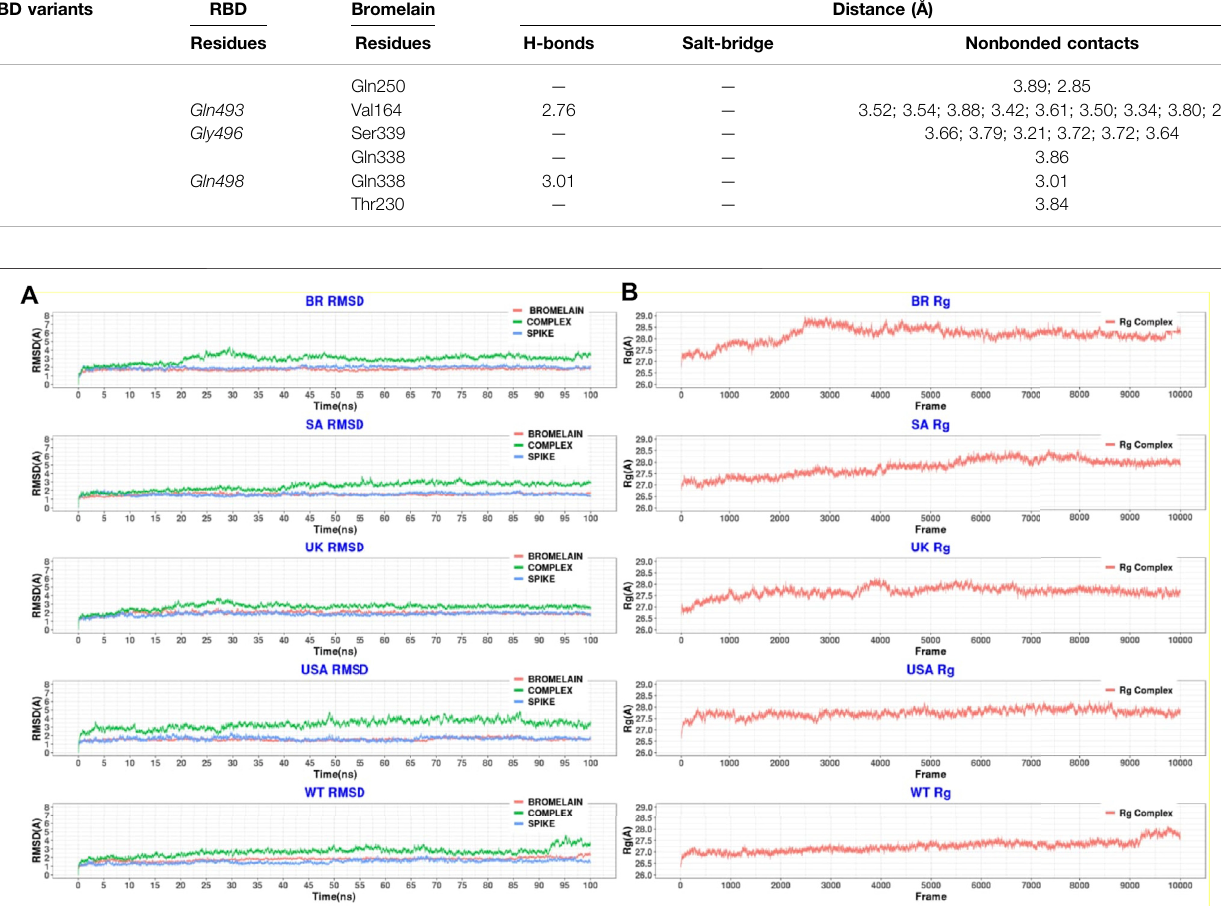
Frontiers in Pharmacology |